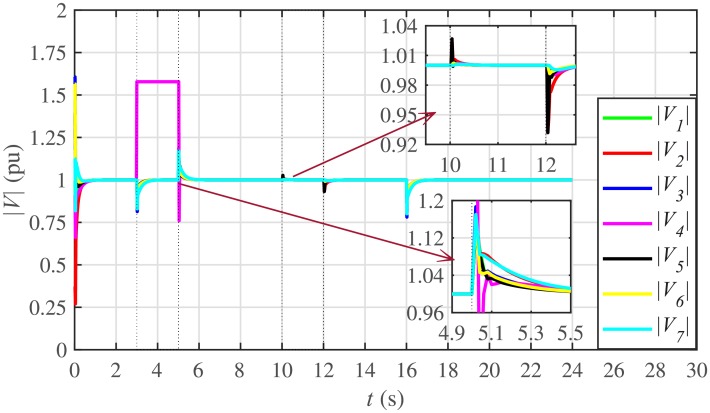
Voltage regulation under case 2.